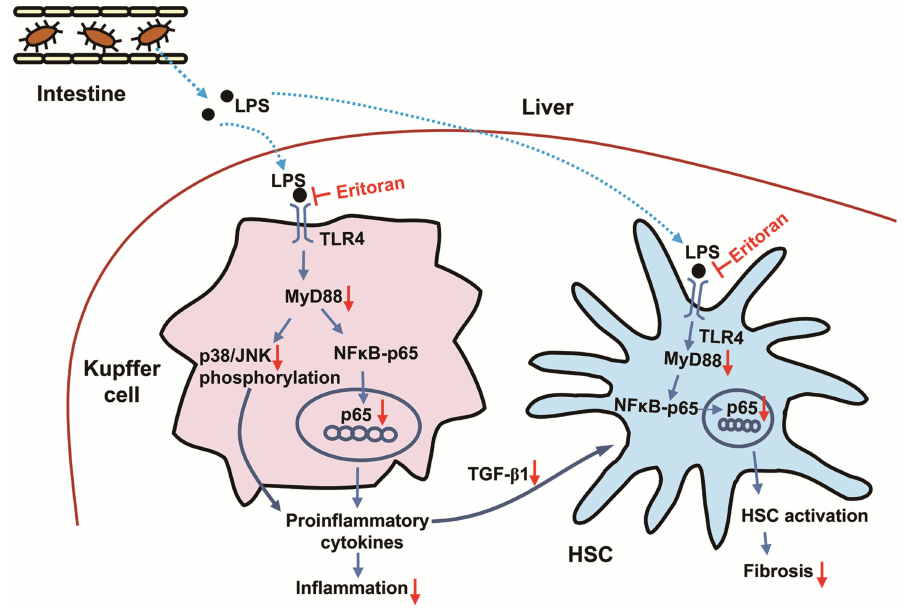
Figure 12. The proposed scheme of the regulation mechanism of eritoran in mice with chronic liver injury. The increased lipopolysaccharide (LPS) due to the increased gut permeability in the fast-food diet-fed or tetrachloride-injured mice [45,46] entered the liver and bound toll-like receptor 4 (TLR4) on the Kupffer cells or hepatic stellate cells (HSCs). In Kupffer cells, LPS activated myeloid differentiation factor 88 (MyD88), leading to the NF- κ B p65 nuclear translocation and increased phosphorylation of p38 and c-Jun N-terminal kinase (JNK), which contributed to increased production of proinflammatory cytokines and inflammation. The secreted transforming growth factor- β 1 (TGF- β 1) from Kupffer cells could promote HSC activation. On the other hand, LPS binding to TLR4